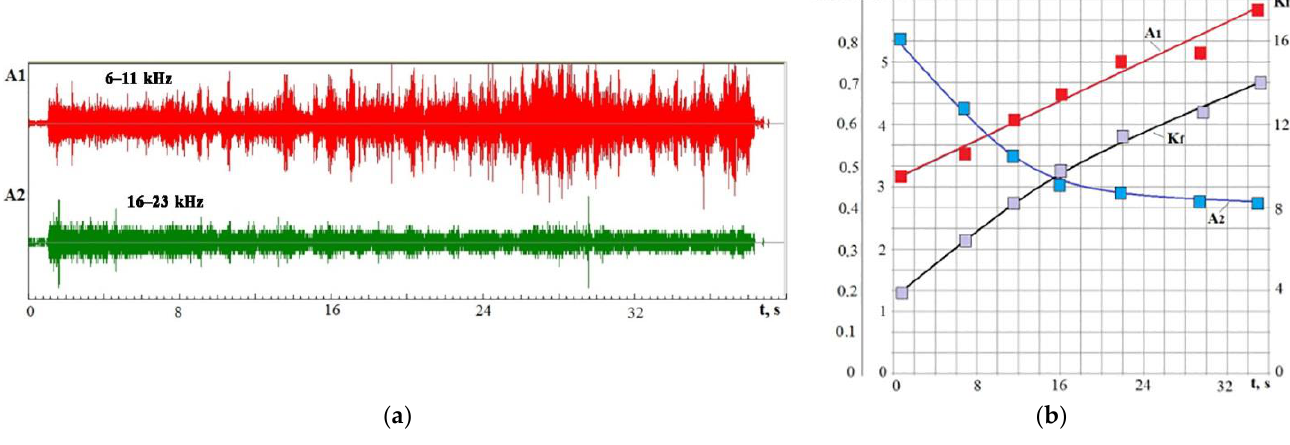
Figure 23. Time recording of VA signals in different frequency ranges in IN23 ceramics die-piercing: ( a ) time recording of signals with amplitudes A 1 and A 2 ; ( b ) change in time of the RMS amplitudes A 1 and A 2 and parameter K f , obtained by dividing the record into 7 intervals.